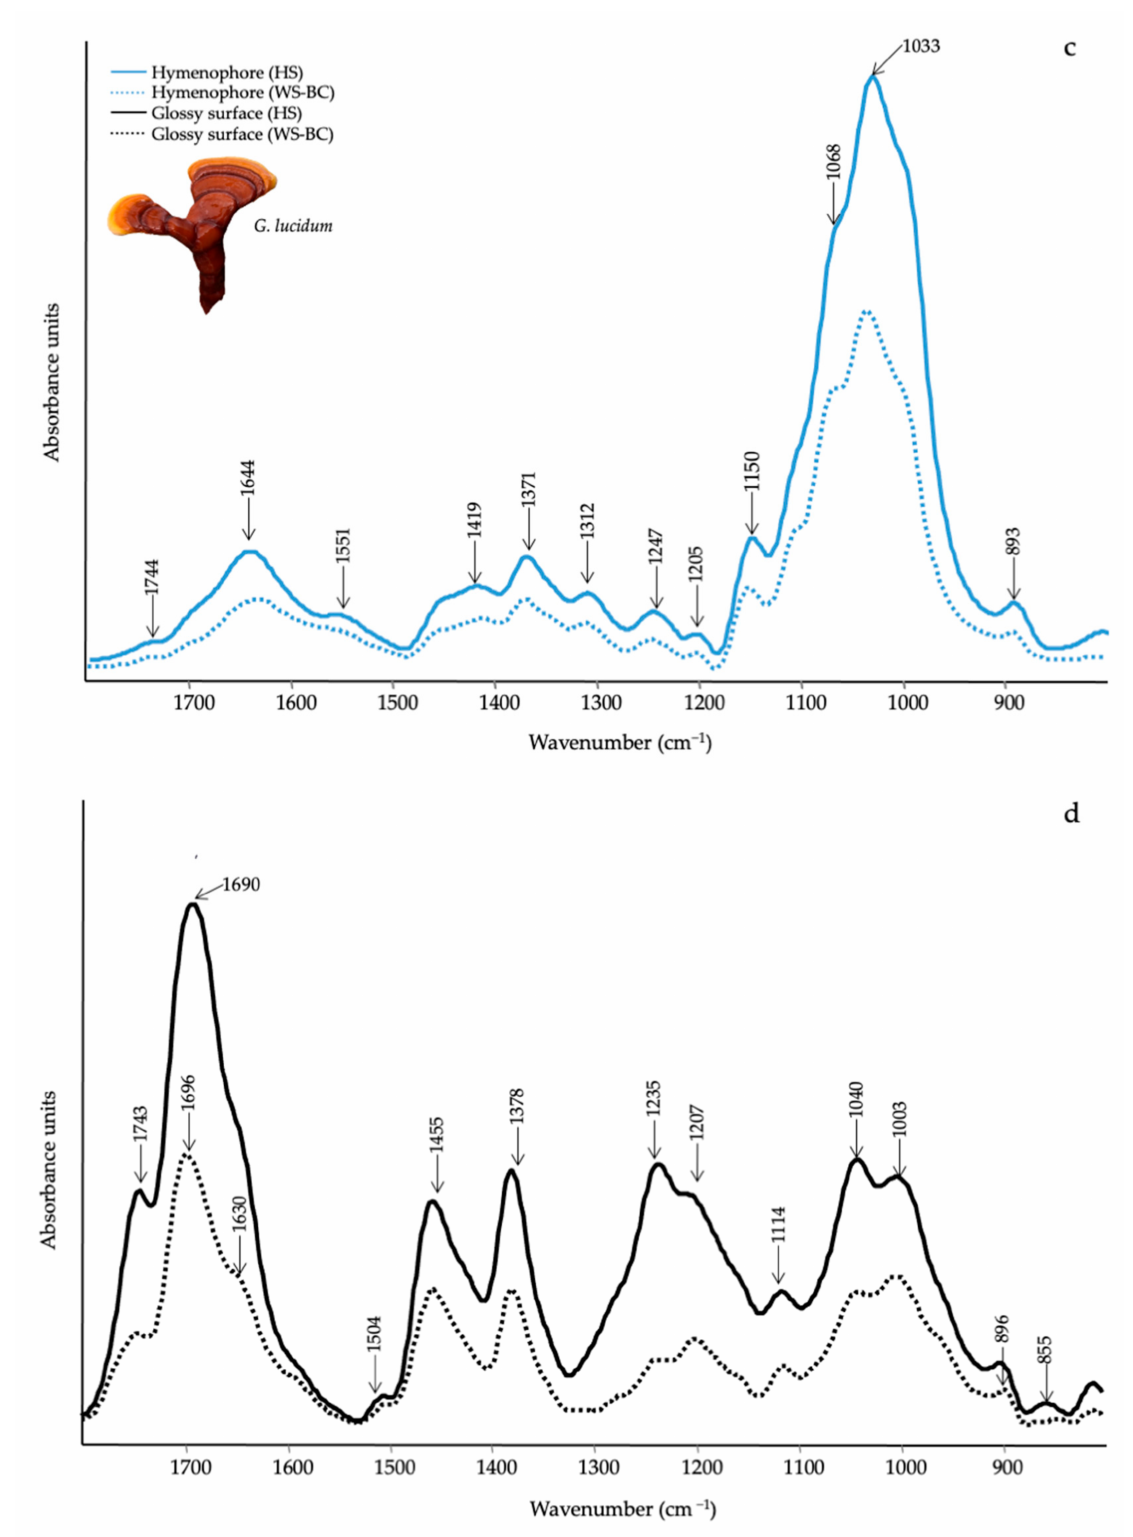
Figure 4. ATR-FTIR spectra of the fruiting bodies of ( a ) P. cornucopiae cultivated on WS-BC (dotted purple line) and HS (solid purple line); ( b ) L. edodes cultivated on WS-BC (dotted green line) and HS (solid green line); ( c ) G. lucidum hymenophore on WS-BC (dotted cyan line) and HS (solid cyan line); ( d ) G. lucidum glossy surface on WS-BC (dotted black line) and HS (solid black